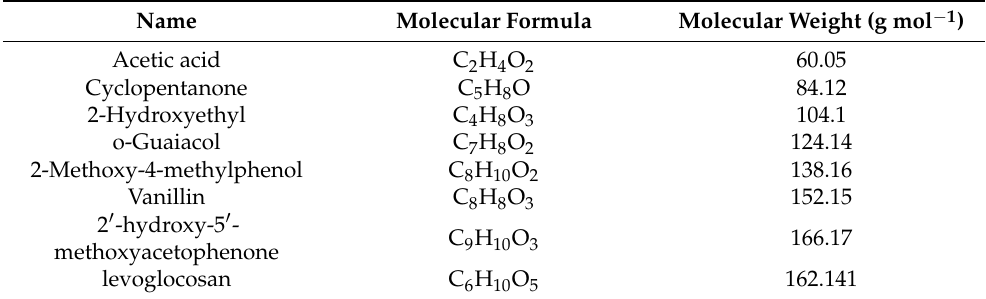
Table 3. List of acid compounds in pyroligneous acid detected by gas chromatography-mass spec- trometry (GC-MS), ordered by molar mass.